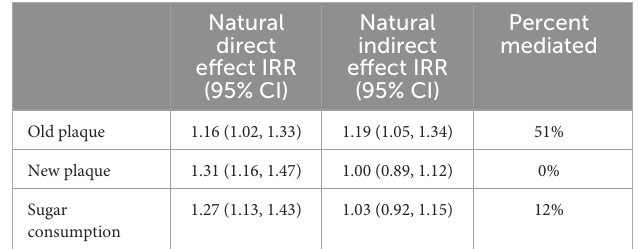
TABLE 4 Causal mediation analysis of oral hygiene and sugar consumption on the association between emotional distress and cavitated lesions at